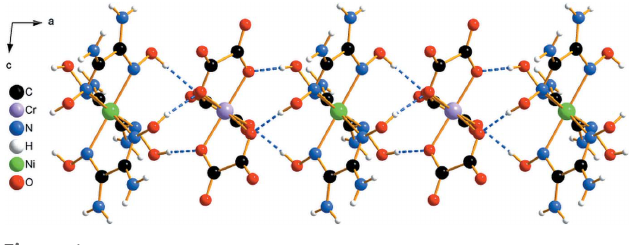
Figure 1 Arrangement of